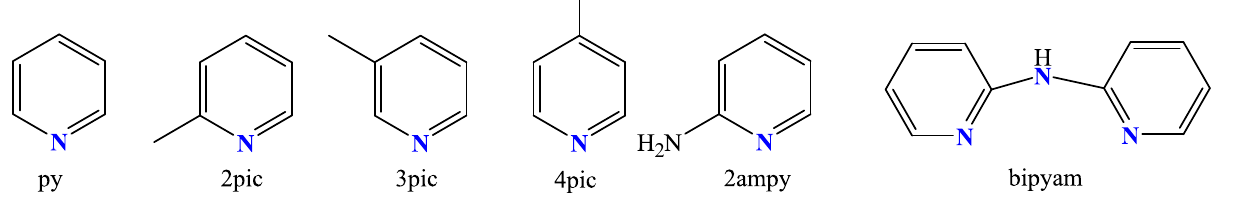
Figure 6. The syntax formula of pyridine derivatives: py = pyridine; 2pic = 2–picoline; 3pic = 3–picoline; 4pic = 4–picoline; 2ampy = 2–aminopyridine and bipyam = 2,2′–bipyridylamine.